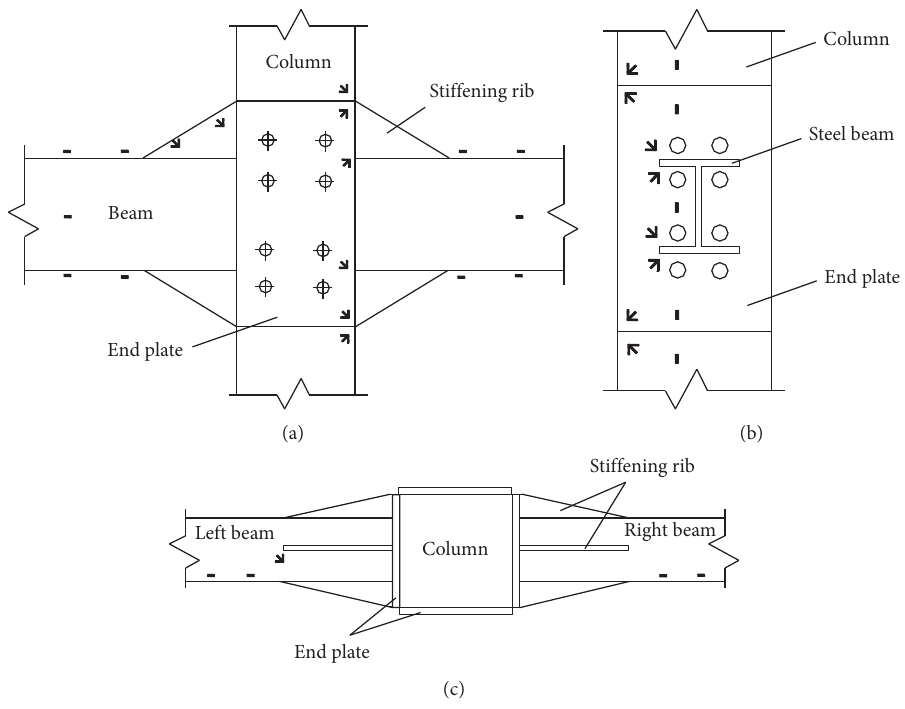
Figure 6: Arrangement of the strain gauges: (a) vertical view; (b) side elevation; (c) plan view.